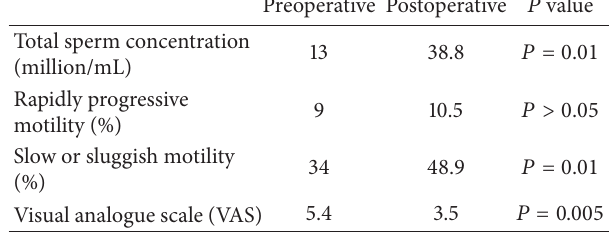
Table 2: Preoperative and postoperative values of total sperm concentration (TSC), rapidly progressive motility (SPa), slow or sluggish motility (SPb), and 10cm visual analogue scale (VAS) in